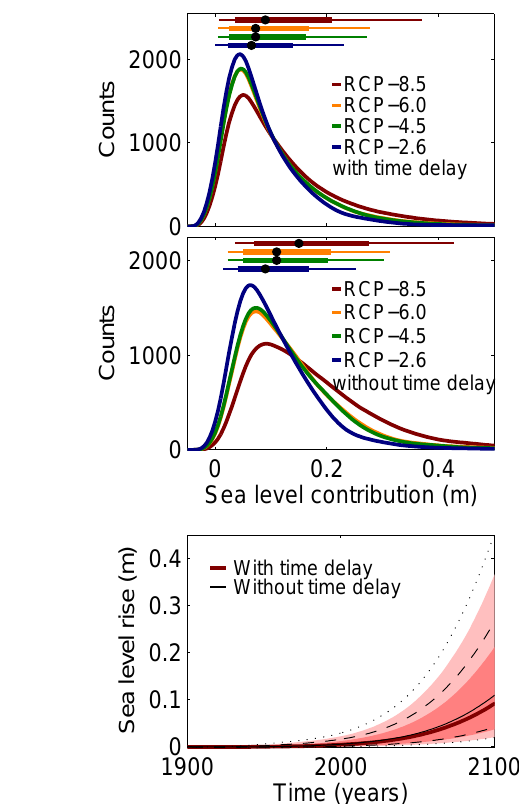
Figure 13. Uncertainty range including climate, ocean and ice- sheet uncertainty for the year 2100. Different colours represent dif- ferent scenarios using the three models including an explicit repre- sentation of ice shelves (PennState-3D, PISM, SICOPOLIS). The upper panel shows the results with time delay as listed in Tables 2– 5. The middle panel shows the results without this time delay. All distributions are highly skewed towards high sea-level contributions which strongly influences the median, the 66% range (thick hori- zontal line at the top of the panel) and the 90% range (thin horizon- tal line at the top of the panel). The scenario dependence is strongest in the higher percentile of the distribution as also visible in the num- bers provided in Table 6. The lower panel shows the corresponding time series of the median, the 66% and the 90% percentile of the distribution with and without time